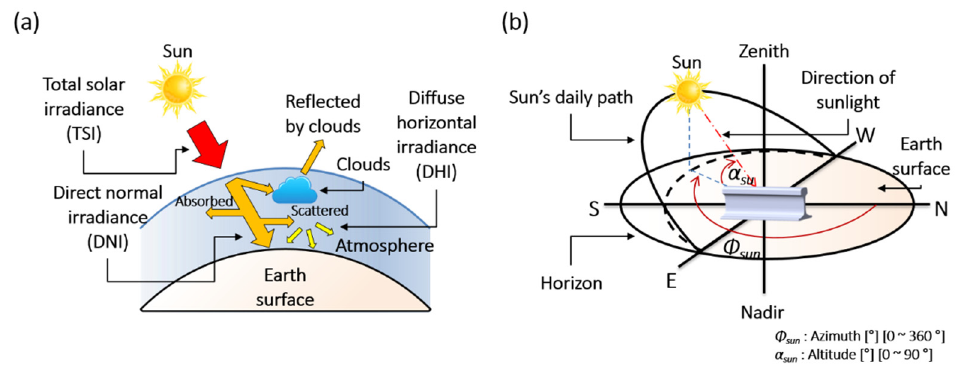
Figure 3. Geometric definitions of ( a ) total solar irradiance (TSI), direct normal irradiance (DNI), and diffuse horizontal irradiance (DHI). ( b ) Azimuth and altitude in the horizontal. coordinate system.